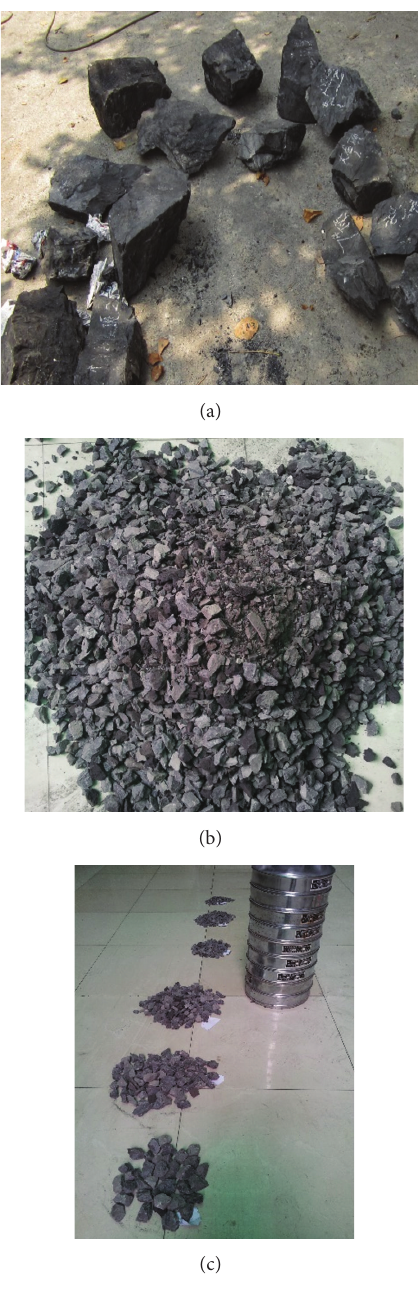
Figure 5: The preparation of gradual spoils in different size ranges: (a) massive gangue; (b) crushed spoils; (c) spoils in different grada-